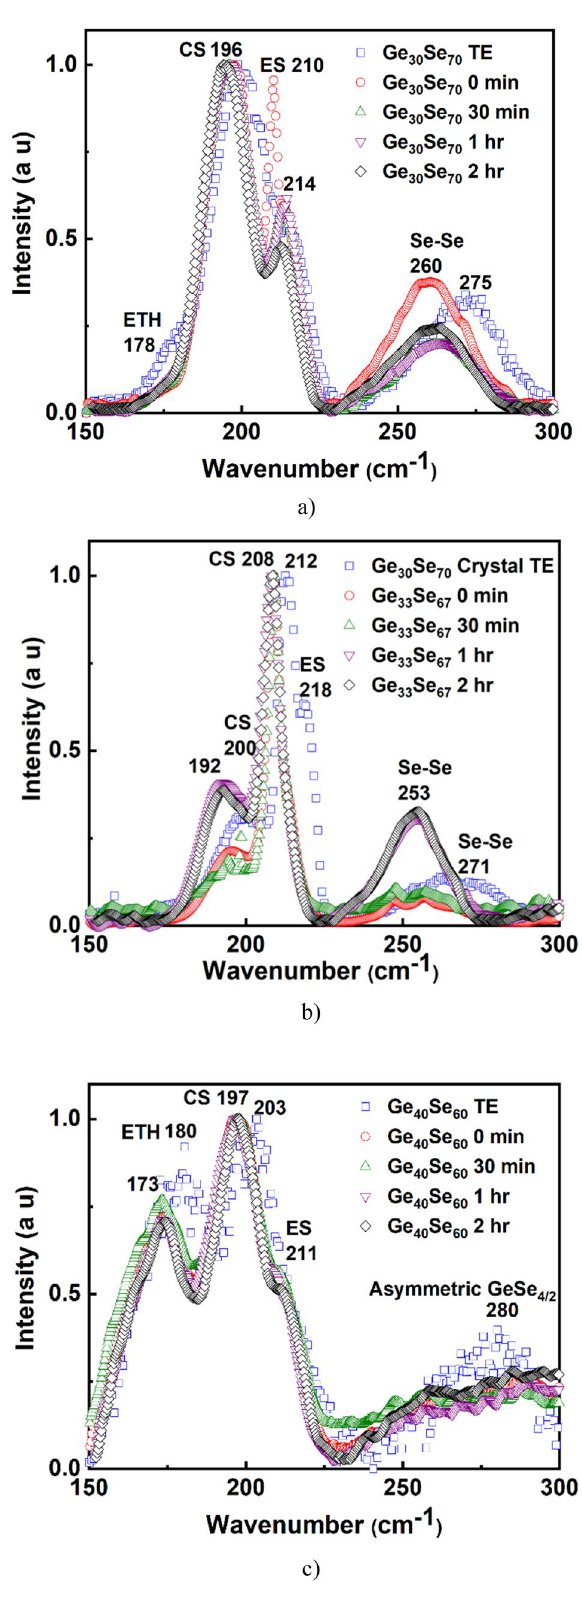
Figure 7. Raman spectroscopy of printed and evaporated films ( a ) Ge 30 Se 70 , ( b ) Ge 33 Se 67 , ( c ) Ge 40 Se 60